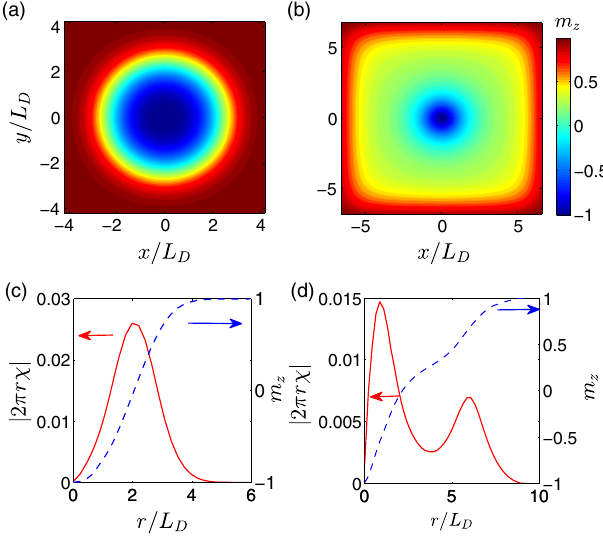
FIG. 4. Internal structure of the skyrmion from 2D square-cell calculation . We show the skyrmion core structure with D=J ¼ 0 . 01 and A J=D 2 ¼ 1 = 2 obtained from a full 2D variational c calculation, which should be compared with circular-cell results shown in Figs. 2(a) and (b). False color plots of m z are shown in the color bar. (c, d) Angle-averaged topological charge density j 2 π r χ ð r Þj and m z ð r Þ (right axes). Panels (a) and (c) correspond to easy-axis anisotropy AJ=D 2 ¼ − 0 . 5 and HJ=D 2 ¼ 0 . 3 . Panels (b) and (d) are for easy-plane anisotropy AJ=D 2 ¼ 1 . 2 and HJ=D 2 ¼ 1 . 1 . Note that the parameters used here are slightly different from those used in Fig. 2; however, the nontrivial structure of the skyrmion core in the easy-axis case is qualita- tively similar to that in the circular-cell